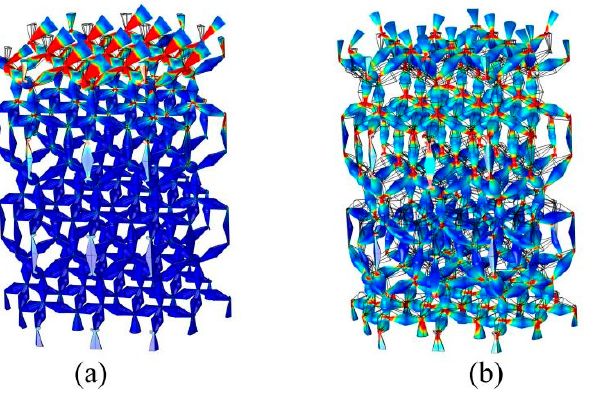
Figure 13. The von Mises stresses of pentamode metamaterials on harmonic loads in ( a ) horizontal direction ( b ) vertical direction.